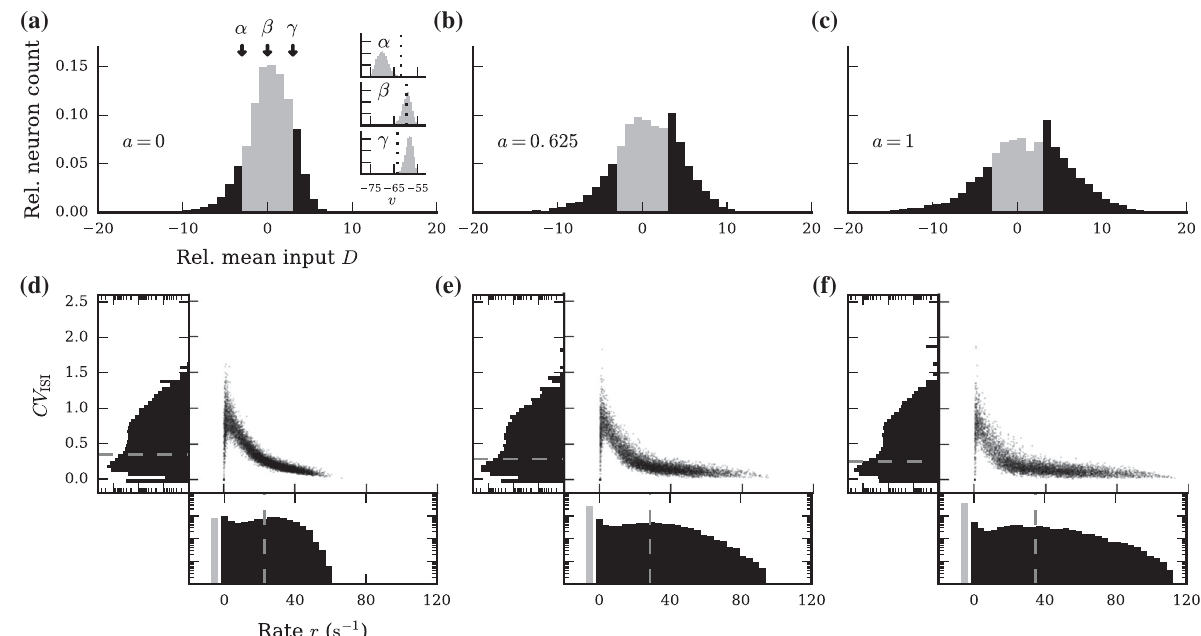
FIG. 6. Modulation of network heterogeneity by leak-conductance calibration (see Sec. II E). Input (top row) and firing statistics (bottom row) in the intact recurrent networks (FB scenarios) for fully calibrated [(a),(d) a ¼ 0 ], partially calibrated [(b),(e) a ¼ 0 . 625 ], and uncalibrated neurons [(c),(f) a ¼ 1 ]. (a) – (c) Effect of calibration on input statistics. Distributions of relative mean input D ¼ ð ¯ v − Θ Þ = σ ð v Þ [distance of time-averaged free membrane potential ¯ v from firing threshold Θ in units of the standard deviation σ ð v Þ ] across the population of neurons. Gray areas in (a) – (c) highlight ½ − 3 ; 3 (cid:2) intervals, containing 74%, 53%, and 42% of the total mass of the distribution, respectively. Inset in (a): Distributions of free membrane potentials v for three neurons α , β , and γ , with D ¼ − 3 , D ¼ 0 , and D ¼ 3 [arrows in (a)], respectively. Dotted lines mark threshold potentials that may vary due to fixed-pattern noise. (d) – (f) Effect of calibration on spike-train statistics. Joint (scatter plots) and marginal distributions of single-neuron firing rates r (horizontal histograms, log-linear scale) and coefficients of variation CV of interspike intervals (vertical histograms, log-linear scale). Dashed lines mark ISI mean of firing rate (22.6, 28.7, 34 . 8 s − 1 ) and CV distributions (0.35, 0.28, 0.25), respectively. Gray bars (bottom panels) represent ISI fractions of silent neurons. Data obtained from M ¼ 50 different network realizations. Percentage of dead neurons: 8%, 26%,